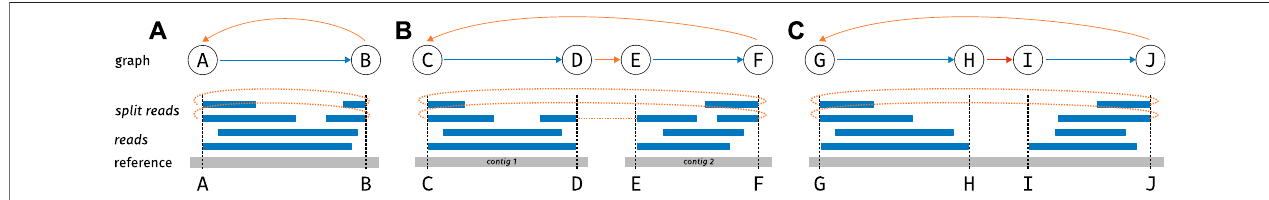
FIGURE1| Example mappings and resultinggraphs.Thelowersectionofeach panelA,B,Cdepictsthemappingofreadstoareference;theupper sectionshow the graph. Inthegraph,nodes correspond togenomic loci (possible breakpoints),blue arrows correspond to coverage edges, red arrows to deletion edges andorange arrows to split edges (A) a simple circle on one contig (B) a circle formed from two parts on different contigs (C) a circle on one contig with a deletion in the middle (deletions are allowed because of library preparation).